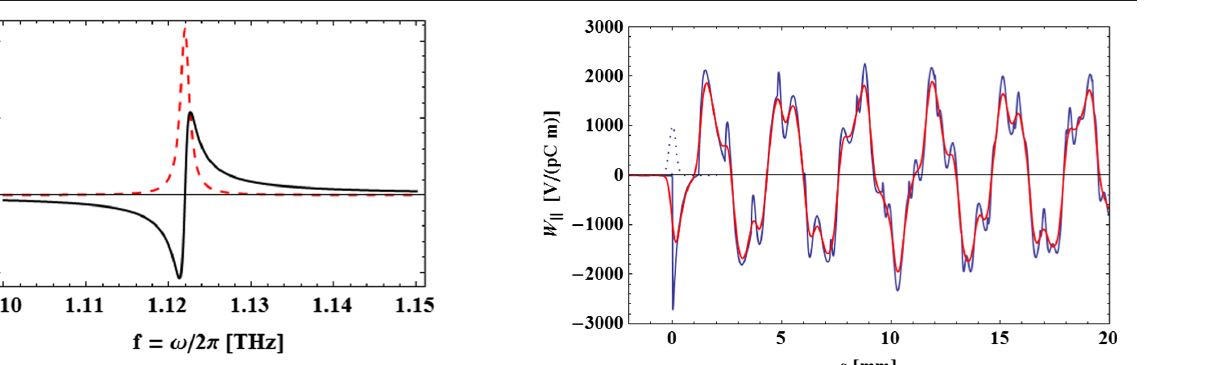
FIG. 16. Comparison of wake functions of a Gaussian bunch ( σ ¼ 0 . 5 ps, red line) and a point particle ( σ ¼ 0 , blue line); ε 00 0 , a ¼ 2 mm, and d ¼ 200 μ m. The dotted line indicates 1 ¼ the bunch